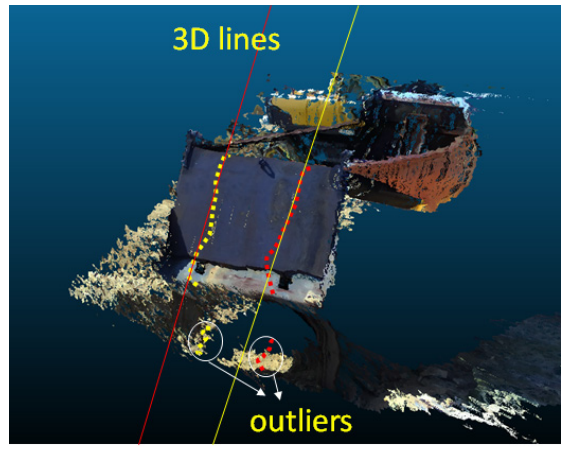
Figure 9. Result of removing outlier point clouds in LiDAR data.